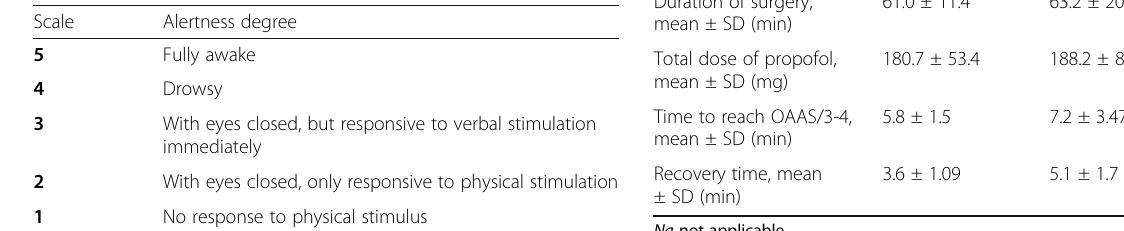
Table 1 Observer ’ s Assessment of Alertness and Sedation (OAAS) scale (Hong et al., 2003)